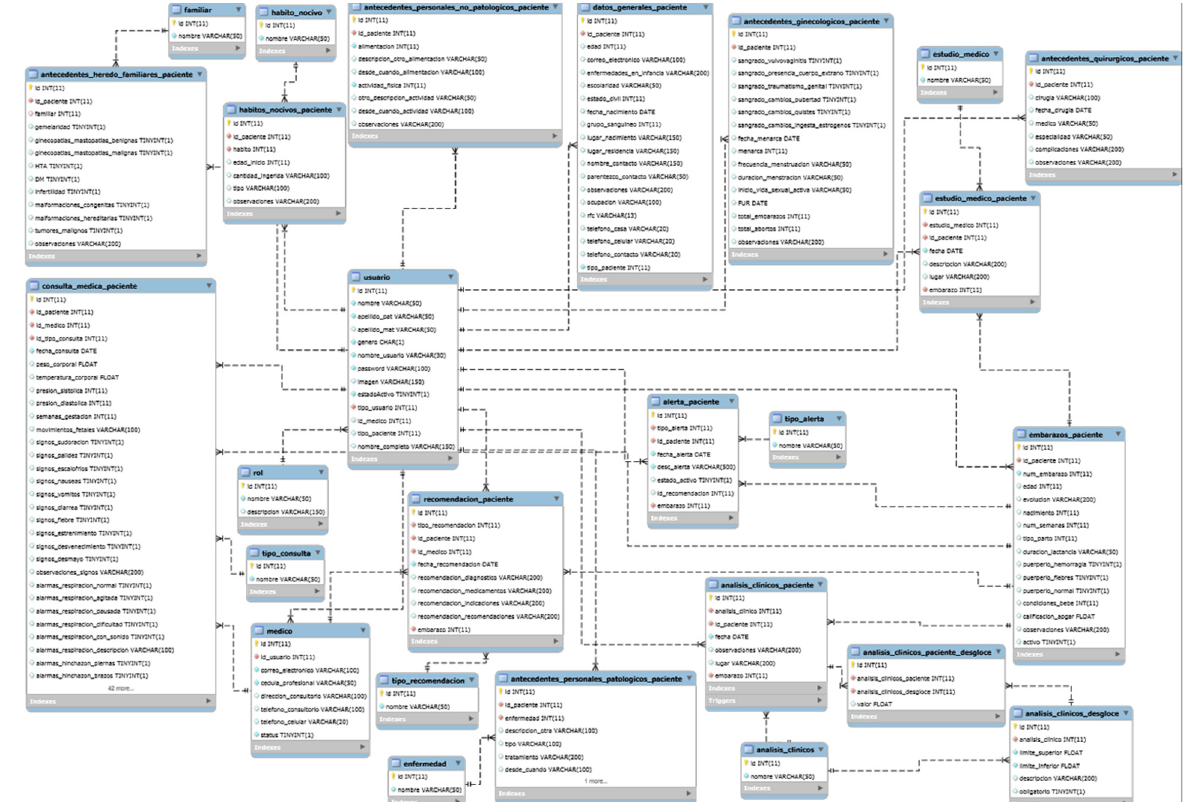
Figure 2. Data model of the telemonitoring system.